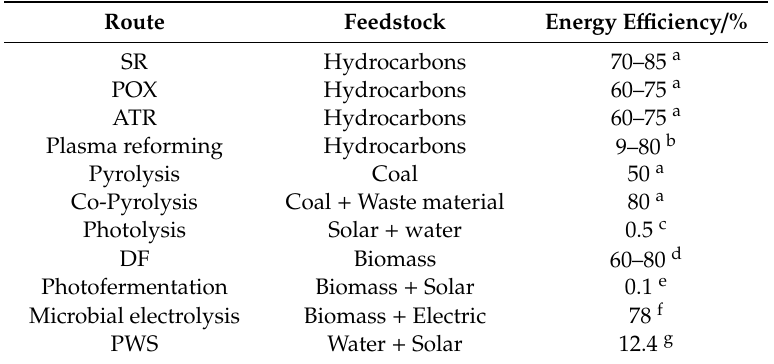
Table 6. The comparisons of di ff erent technical routes for hydrogen production, and their e ff ectiveness.